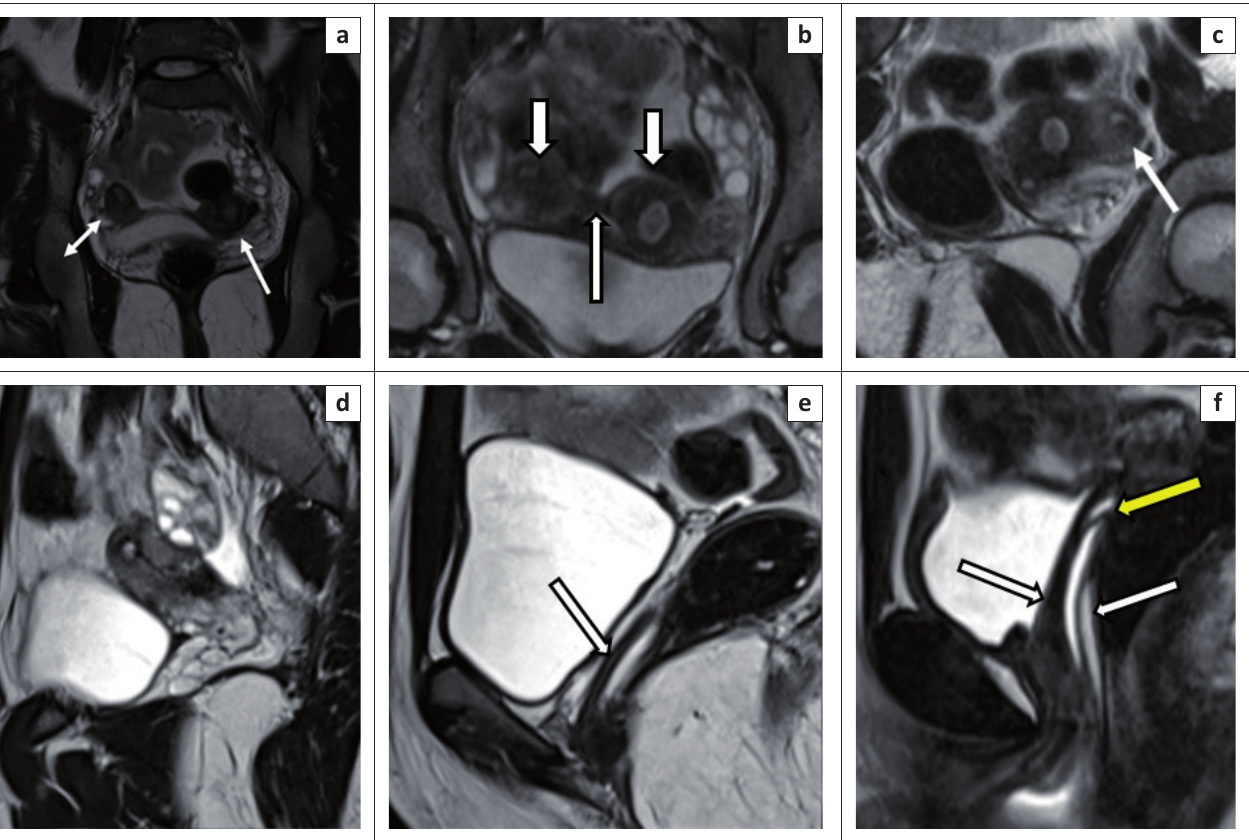
FIGURE 17: Coronal T2 sequence (a) demonstrates a uterus with endo-myometrial differentiation on the left (white arrow) and an additional uterus-like structure (double-headed arrow) on the right side attached to the left-sided uterus by a fibrous band. (b) Coronal T2 thick maximum intensity projection (MIP) delineates well both uteri (white arrows) and connecting fibrous band (long white arrow). (c) Oblique reformation of the left-sided uterus shows a unicornuate uterus with a rudimentary non-communicating horn (white arrow). (d) Sagittal T2 sequence shows cervical aplasia. (e) Sagittal T2 sequence demonstrates the blind-ended vagina (white arrow). (f) Sagittal T2 sequence with vaginal gel instillation shows a transverse septum superiorly (yellow arrow) and a longitudinal septum (white arrows) in the lower